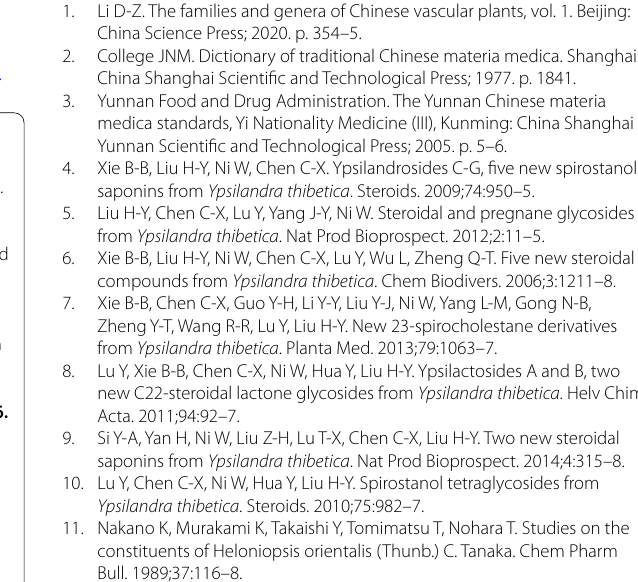
Fig. S9. 13 C NMR spectrum (125 MHz) of compound 2 in pyridine‑ d 5 . Fig. S10. 1 H– 1 H COSY spectrum of compound 2 in pyridine‑ d 5 . Fig. S11. HSQC spectrum of compound 2 in pyridine‑ d 5 . Fig. S12. HMBC spectrum of compound 2 in pyridine‑ d 5 . Fig. S13. ROESY spectrum of compound 2 in pyridine‑d5. Fig. S14. HRESI ( ) MS spectrum of compound 2 . Fig. + S15. 1 H NMR spectrum (500 MHz) of compound 3 in pyridine‑ d 5 . Fig. S16. 13 C NMR spectrum (125 MHz) of compound 3 in pyridine‑ d 5 . Fig. S17. 1 H– 1 H COSY spectrum of compound 3 in pyridine‑ d 5 . Fig. S18. HSQC spectrum of compound 3 in pyridine‑ d 5 . Fig. S19. HMBC spectrum of compound 3 in pyridine‑ d 5 . Fig. S20. ROESY spectrum of compound 3 in pyridine‑ d 5 . Fig. S21. HRESI ( ) MS spectrum of compound 3 . Fig. S22 + 1 H NMR spectrum (500 MHz) of compound 4 in pyridine‑ d 13 C 5 . Fig. S23. NMR spectrum (125 MHz) of compound 4 in pyridine‑ d 5 . Fig. S24. 1 H– 1 H COSY spectrum of compound 4 in pyridine‑ d 5 . Fig. S25. HSQC spectrum